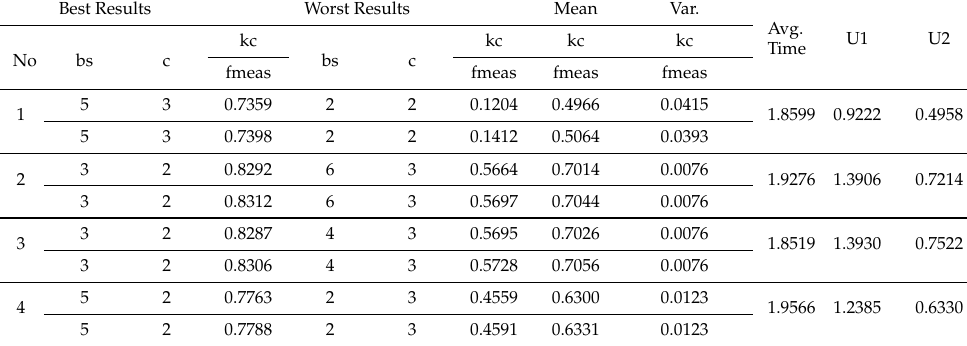
Table A7. Results of